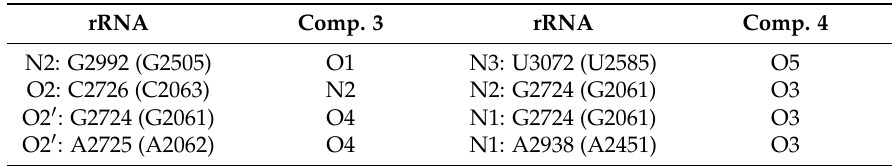
Table 5. Hydrogen bond pairs $ between atoms of mitochondrial rRNA and of compounds 3 and 4 # . Corresponding bases of E. coli 23S rRNA are noted in parenthesis. The matching of RNA nucleotides was based on data from Brown et al. [33]. rRNA Comp. 3 rRNA Comp. 4 N2: G2992 (G2505) O1